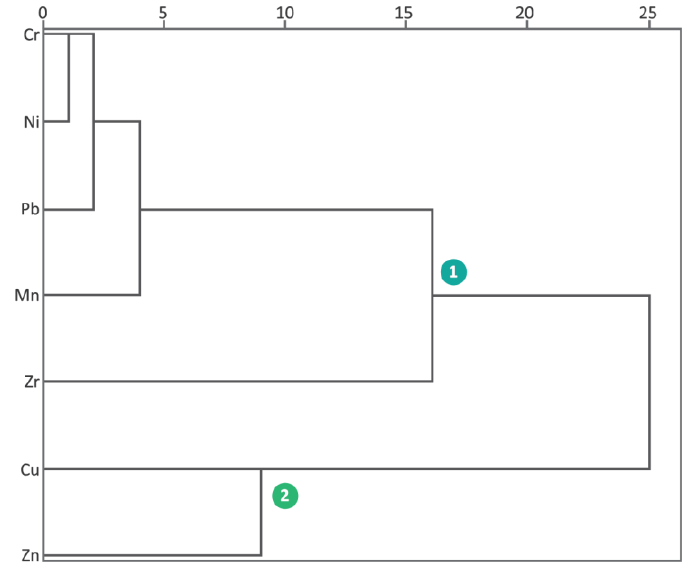
Figure 3. Hierarchical cluster analysis of the selected